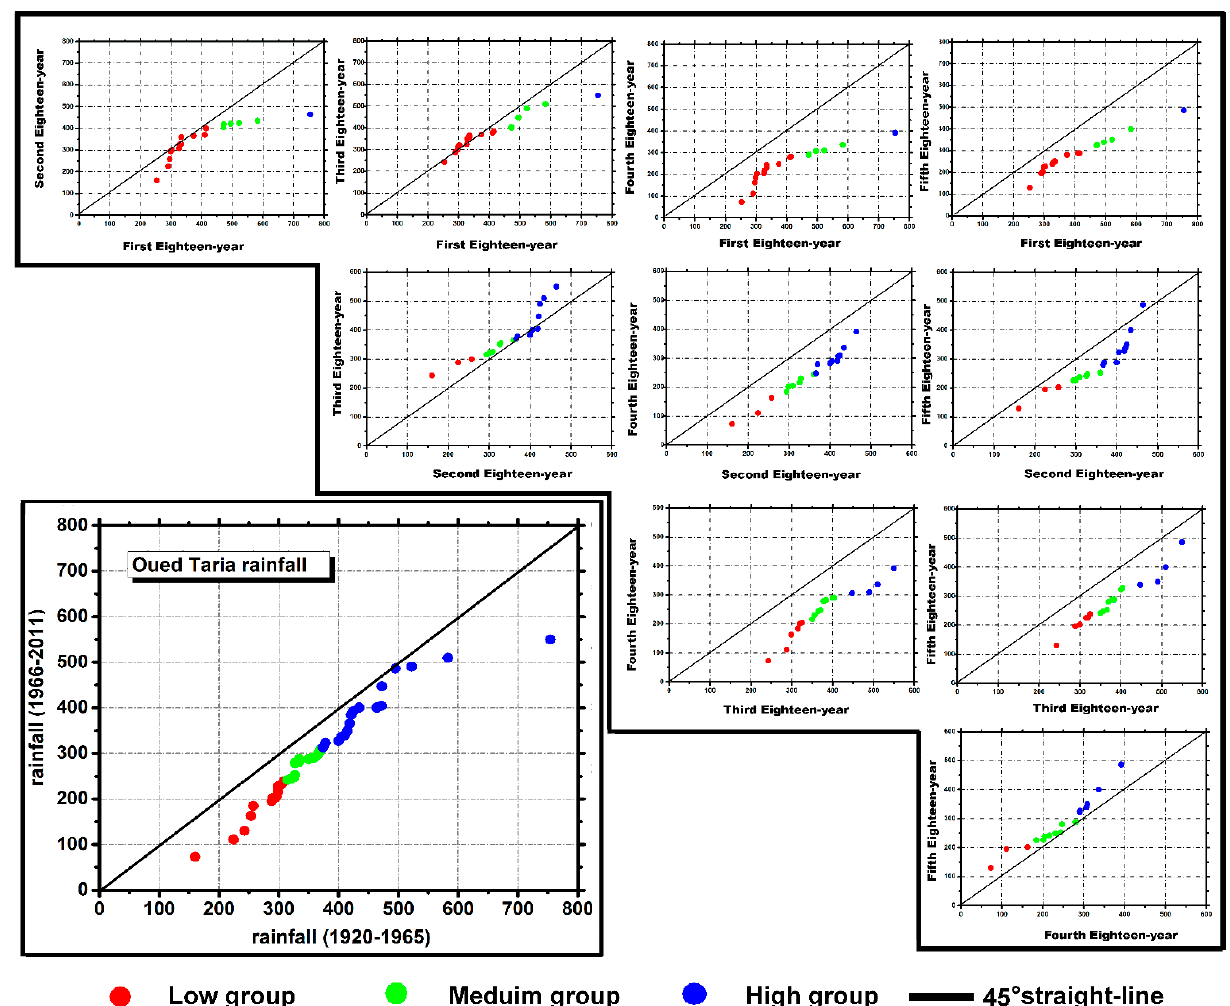
Figure 4. Triangular trend analysis methodology applied on rainfall series of Oued Taria.